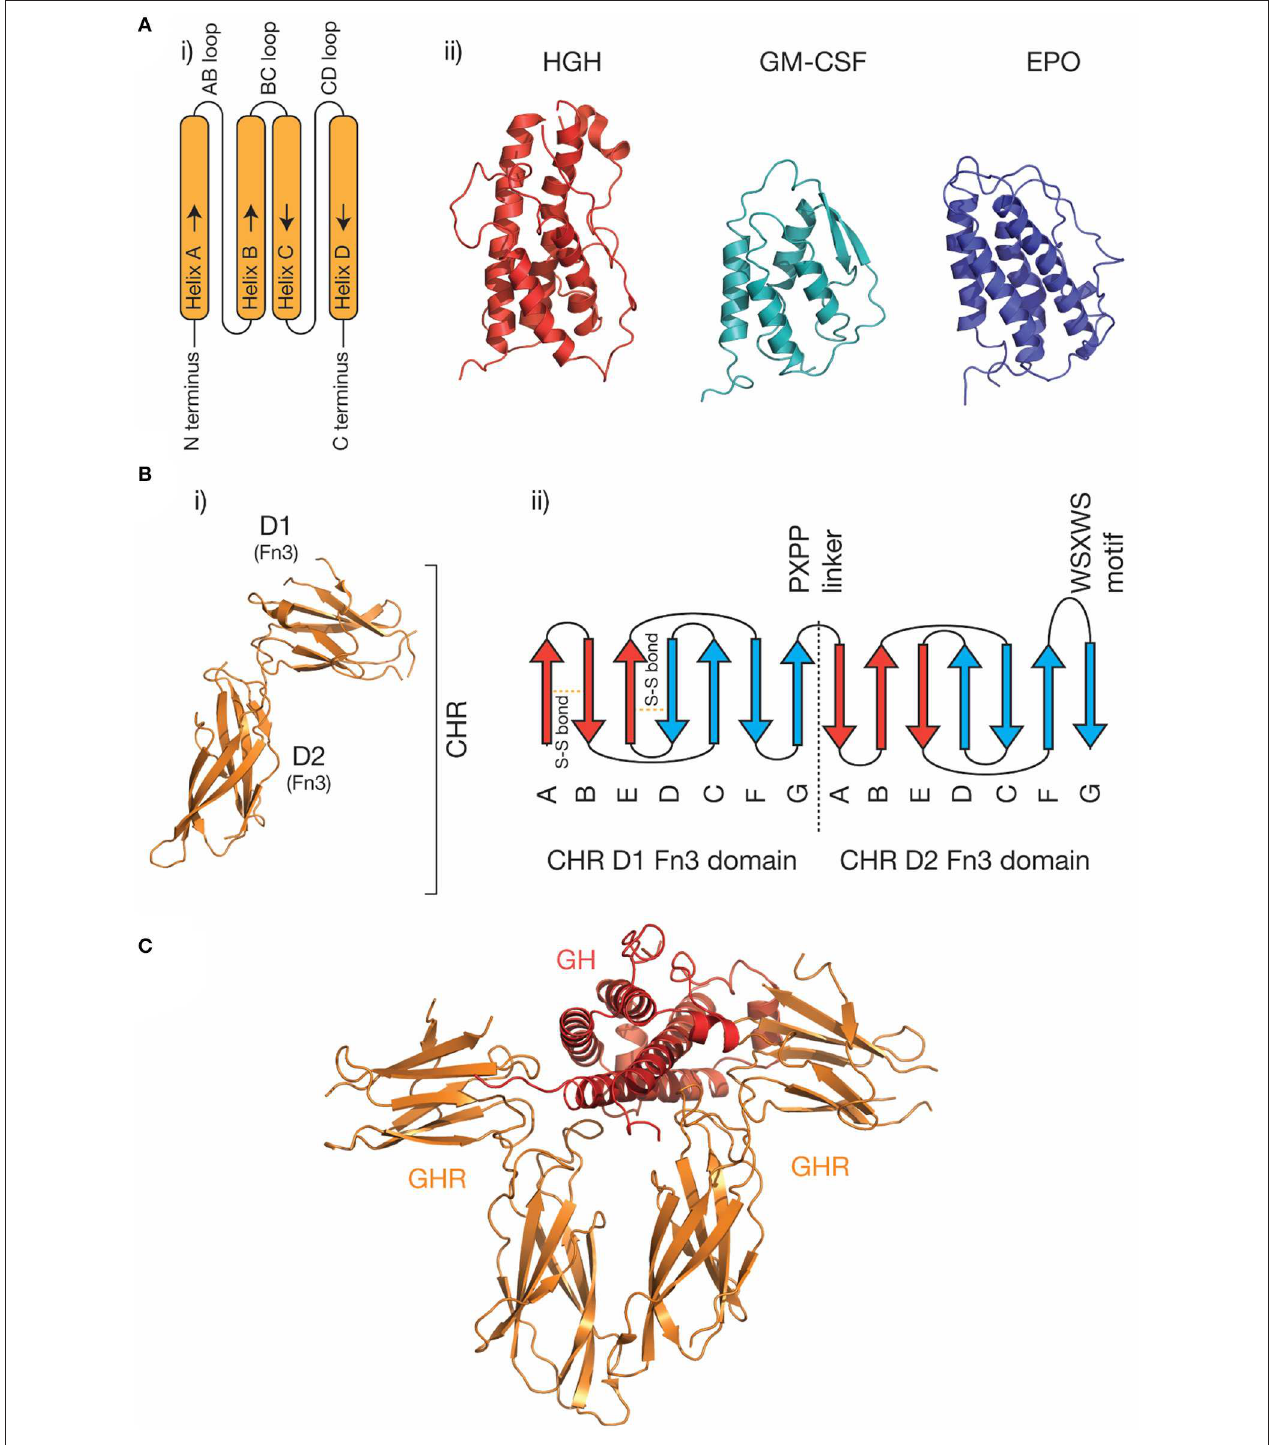
FIGURE 1 | The structure of cytokines and receptors. (A) (i) A schematic of the four- α helical bundle topology of hematopoietic cytokines, (ii) cartoon representations of the structures of several representative cytokines; human growth hormone [PDB ID: 1HGU (40)], GM-CSF [PDB ID: 1CSG (41)], and erythropoietin [PDB ID: 1BUY (42)]. (B) The structure of the growth hormone receptor [PDB ID: 2AEW (43)]. The two Fn3 domains that make up the CHR are indicated, and a typical topology (30) for the two Fn3 domains in the CHR is shown in (ii). The conserved disulfide bonds in the N-terminal domain, the linker sequence, and the conserved WSXWS motif are indicated. (C) The structure of the growth hormone/growth hormone receptor complex [PDB ID: 3HHR (44)].